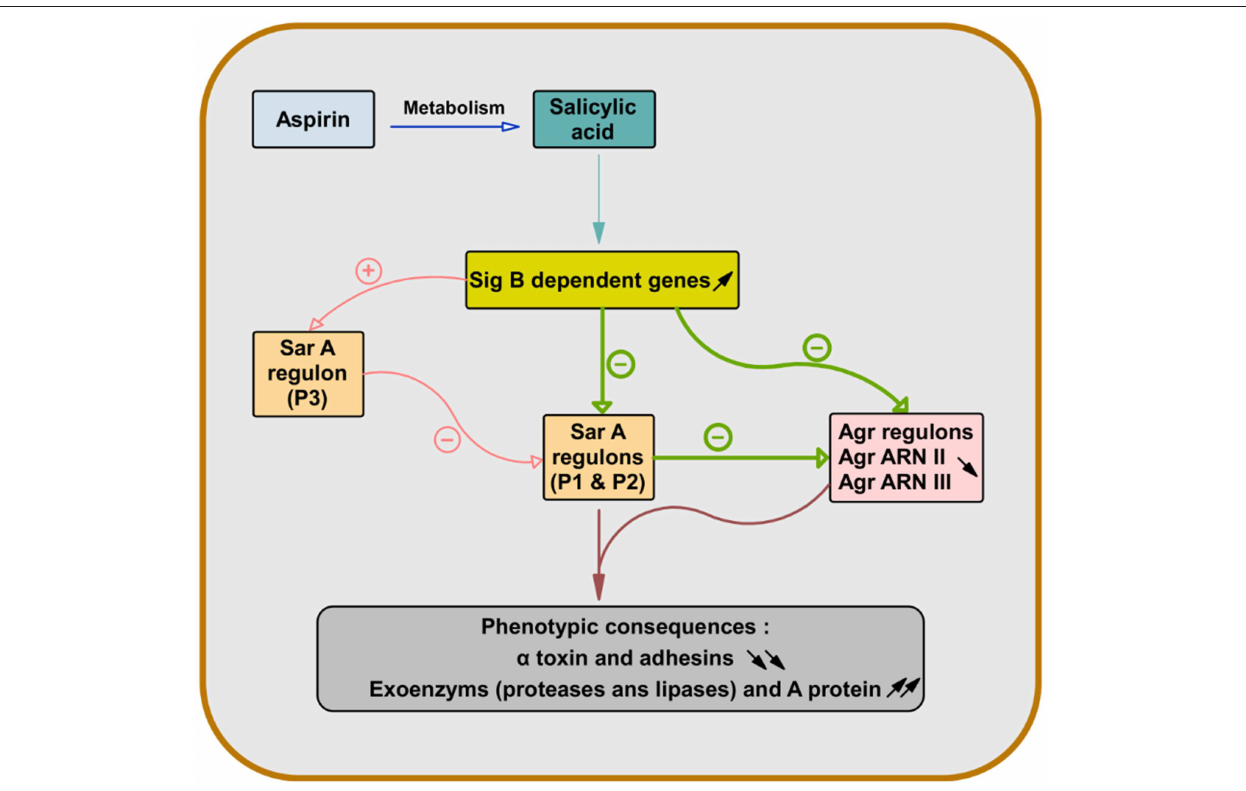
FIGURE 1 | Role of salicylic acid in the gene regulation of S. aureus virulence factors. After deacetylation of aspirin, salicylic acid causes overexpression of sigma factor B-dependent genes. This leads to repression of genes dependent on staphylococcal accessory regulator A (SarA) (Sar P1 and P2) and accessory gene regulator (Agr) (Agr RNA II and Agr RNA III) in S. aureus . Since the expression of the α -toxin gene (hla) is dependent on both Sar and Agr and the expression of the wall-bound adhesins genes are also controlled by Sar, the pretreatment of S. aureus with salicylic acid leads to their attenuation and increases the production of exoenzyme and protein A